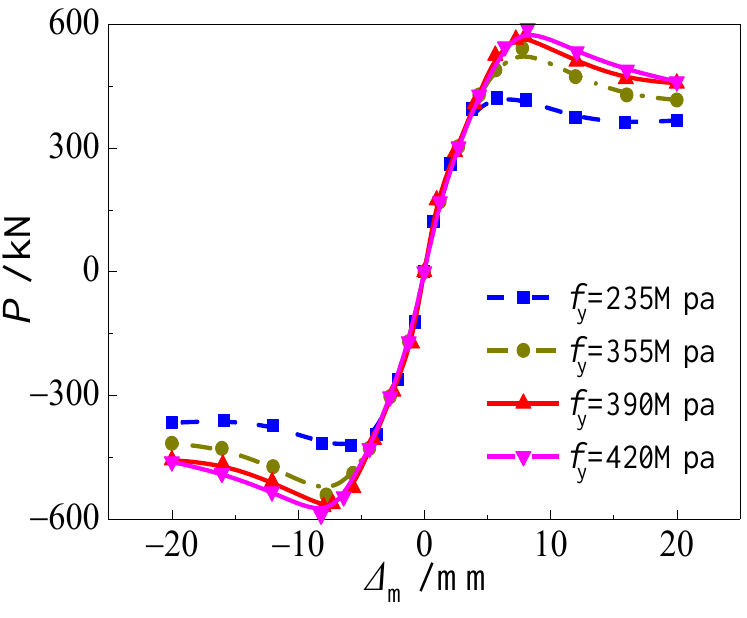
Figure 14. Effect of yield strength of steel tube on skeleton curve.